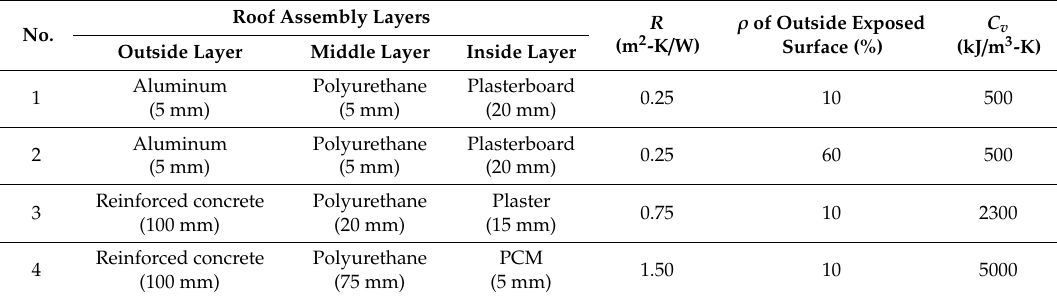
Figure 2. E ff ects of thermo-physical and solar radiation properties on ( a ) annual heat gain and ( b ) R eq -value for common roof construction materials (filled pattern represents roof assemblies with a cool coating ( ρ = 80%) and without pattern represents roof assemblies without cool coating ( ρ = 10%)). Table 2. Thermo-physical properties of common roof construction